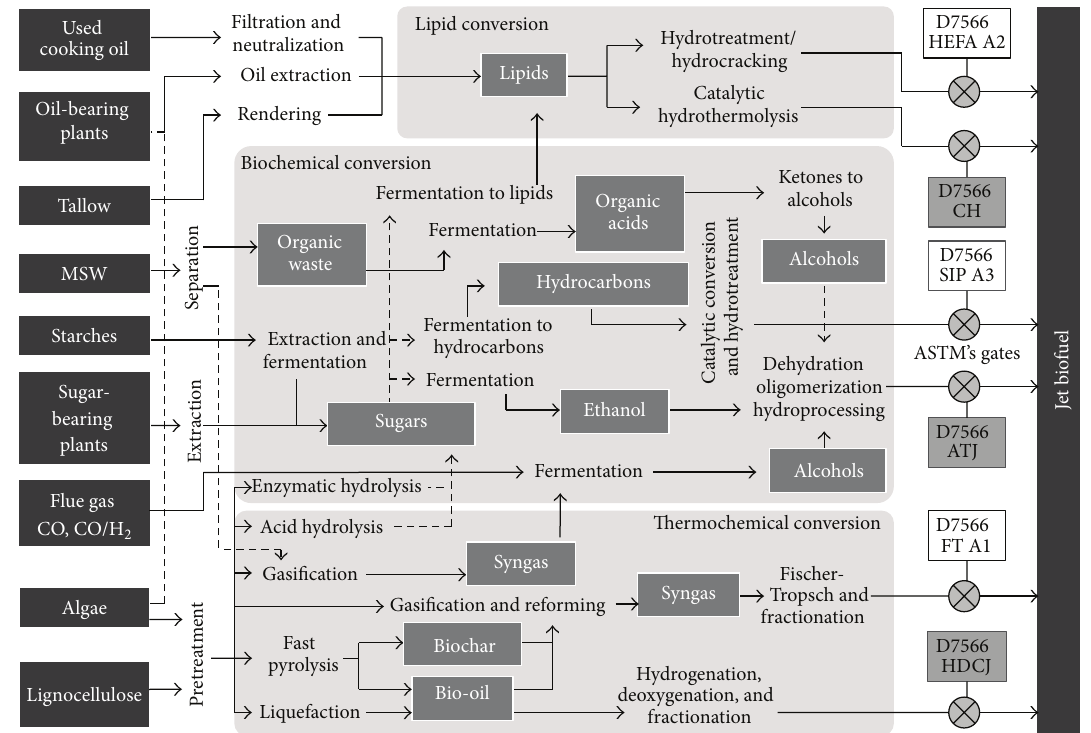
Figure 6: Identified pathways for the production of sustainable jet biofuels in